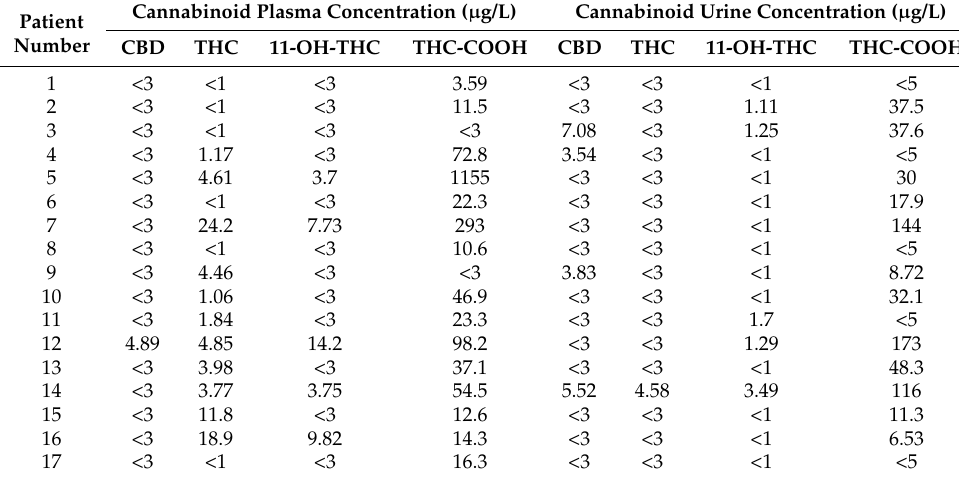
Table 1. Cannabinoid concentrations measured by GC/MS in plasma and urine samples of MS patients. CBD, THC, 11-OH-THC, and THC-COOH were measured by GC/MS in plasma and in non-hydrolyzed urine samples. Plasma or urine samples (1.0 mL) were extracted as described, and CBD, THC, 11-OH-THC, and THC-COOH were determined by GC/MS analysis after silylation with N-methyl-N-(trimethylsilyl)-trifluoroacetamide. Cannabinoid Plasma Concentration ( µ g/L) Cannabinoid Urine Concentration ( µ g/L) Patient Number CBD